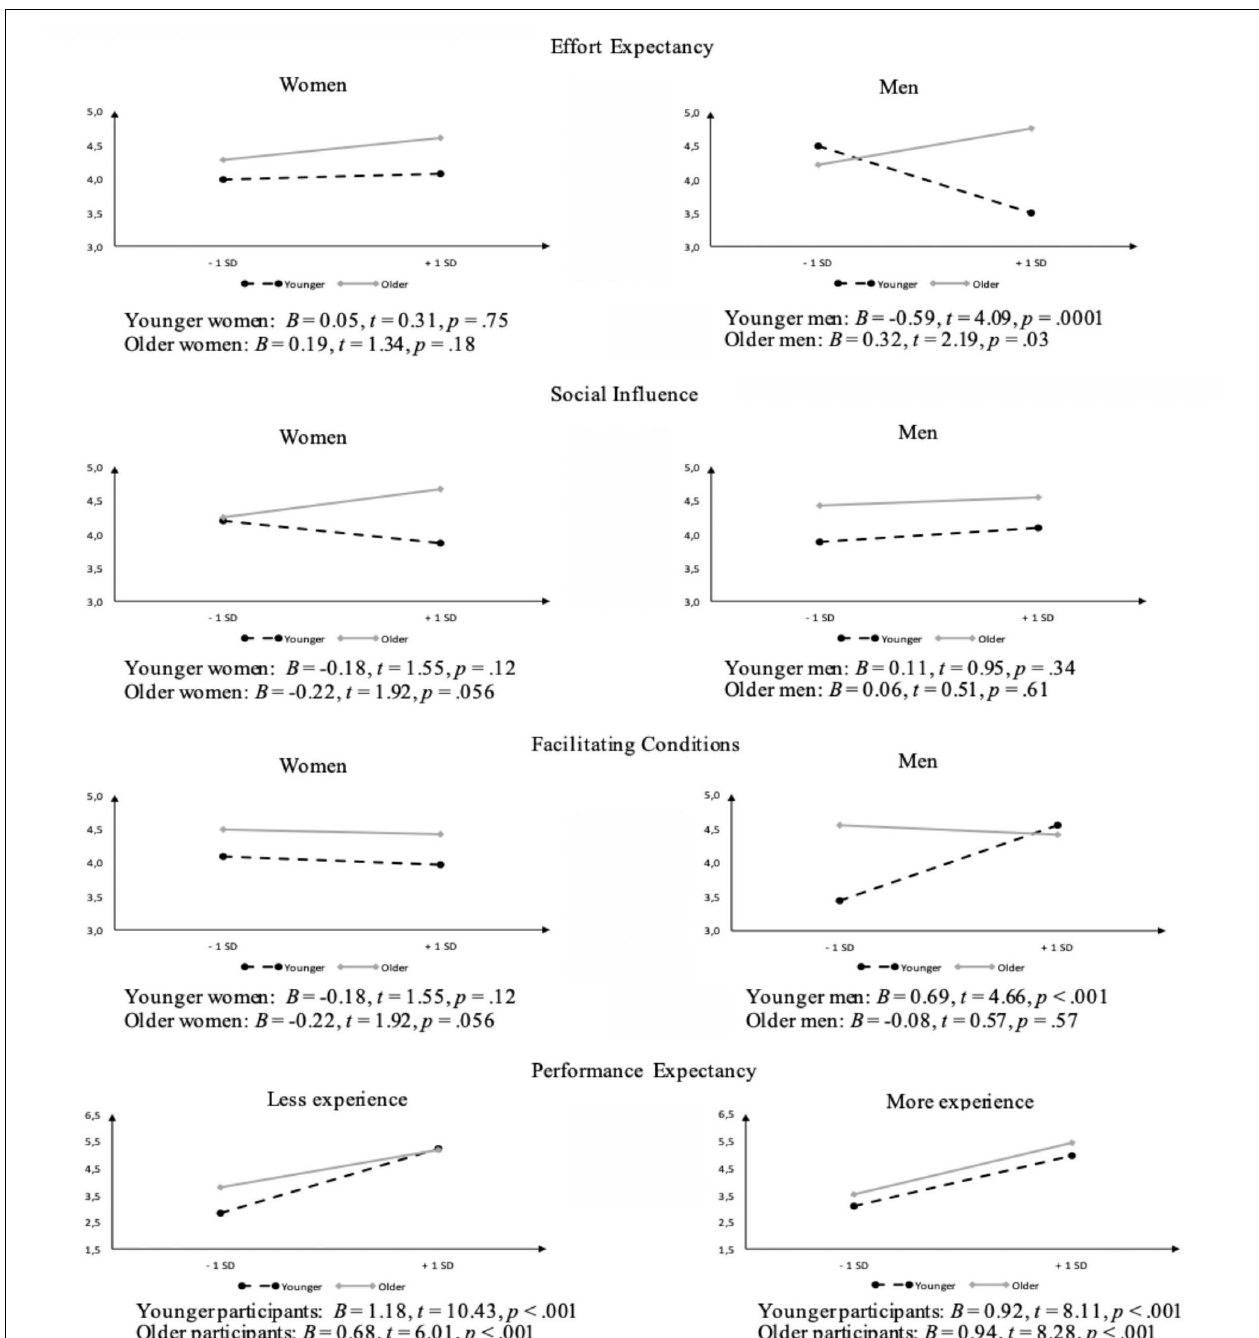
FIGURE 1 | Graphs depicting the four significant three-way interactions.